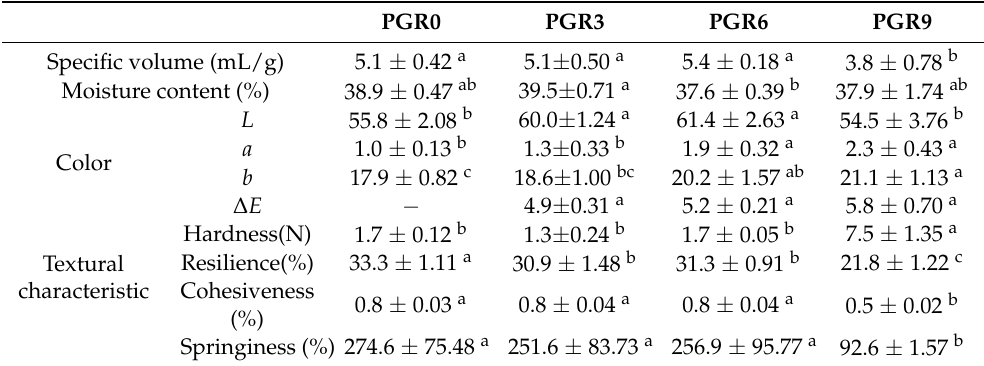
Table 2. Basic quality of wheat bread enriched with different addition amounts of PGR